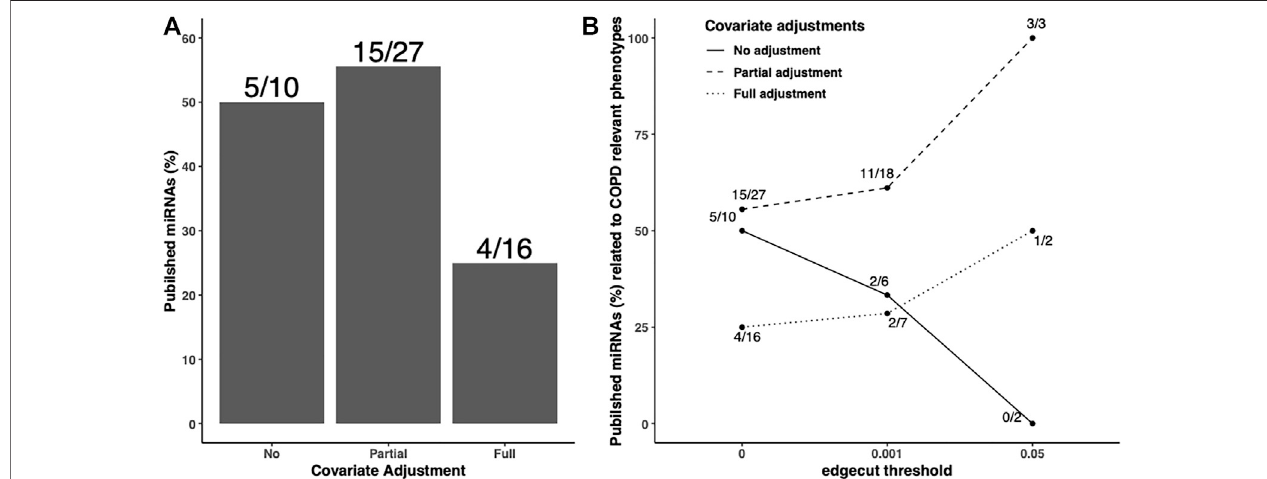
FIGURE 4 | Published COPD-associated miRNA percentage in the identi fi ed FEV 1 pp-networks with different adjustment strategies. Scaled SmCCNet were applied on the unadjusted, partially adjusted, or fullyadjusted miRNA and mRNA data with FEV 1 ppphenotype. To compare the quality of FEV 1 pp-associatednetworks, the miRNAs in the identi fi ed networks were mapped with the list of published COPD-associated miRNAs (A). The denominators on each bar are the number of miRNAs associated with FEV 1 pp with different adjustment as indicated. The numerators are the number of validated miRNAs related to COPD. We applied 0.001 and 0.05 edge thresholds to fi lter weak edges between miRNAs and mRNAs and the remaining miRNAs were used to calculate the published COPD-associated miRNA percentage in unadjusted, partially adjusted, and fully adjusted.